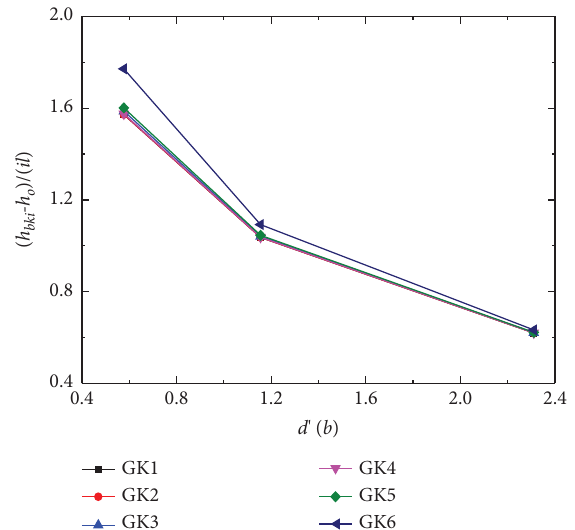
Figure 16: Variation in the MWLIR with the efective depth-width ratio of the structure in a two-layer soil ( d � 30m, x �− l /2).